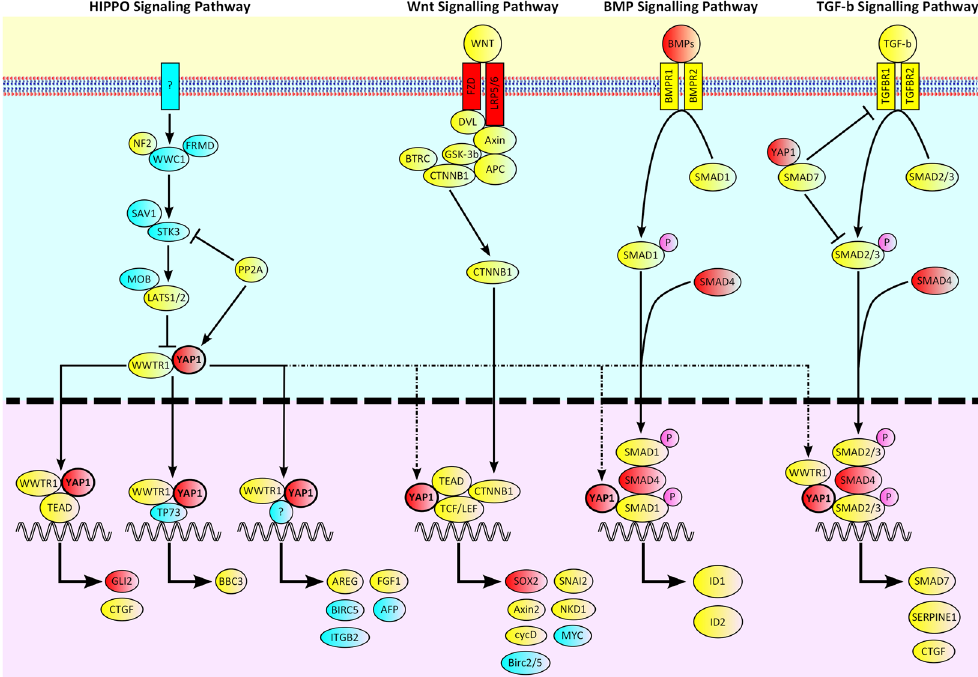
Figure 1. Cartoon illustrating the pathways with which YAP1 interacts. Known anophthalmia, microphthalmia and coloboma genes are coloured red. Genes implicated in eye function are coloured yellow. Genes not yet implicated in eye development or function are coloured